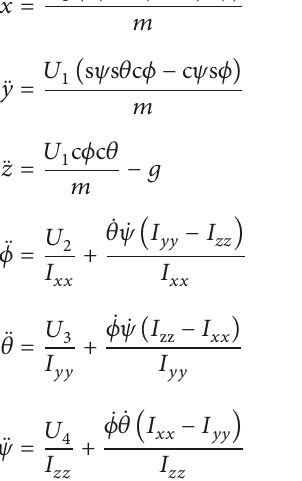
Figure 2: Analysis of the main and lateral